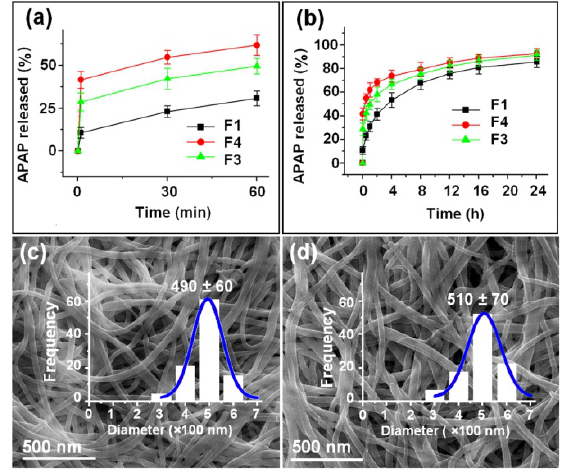
Figure 6. In vitro dissolution tests: ( a and b ) In vitro drug release profiles of the APAP-loaded nanofibers F1 (prepared by single fluid electrospinning), F3, and F4 (prepared by coaxial electrospinning) at the first 60 min and the full range, respectively; ( c and d ) FESEM images and size distribution of the core part of nanofibers F3 and F4 after the removal of the shell part in the first phase.